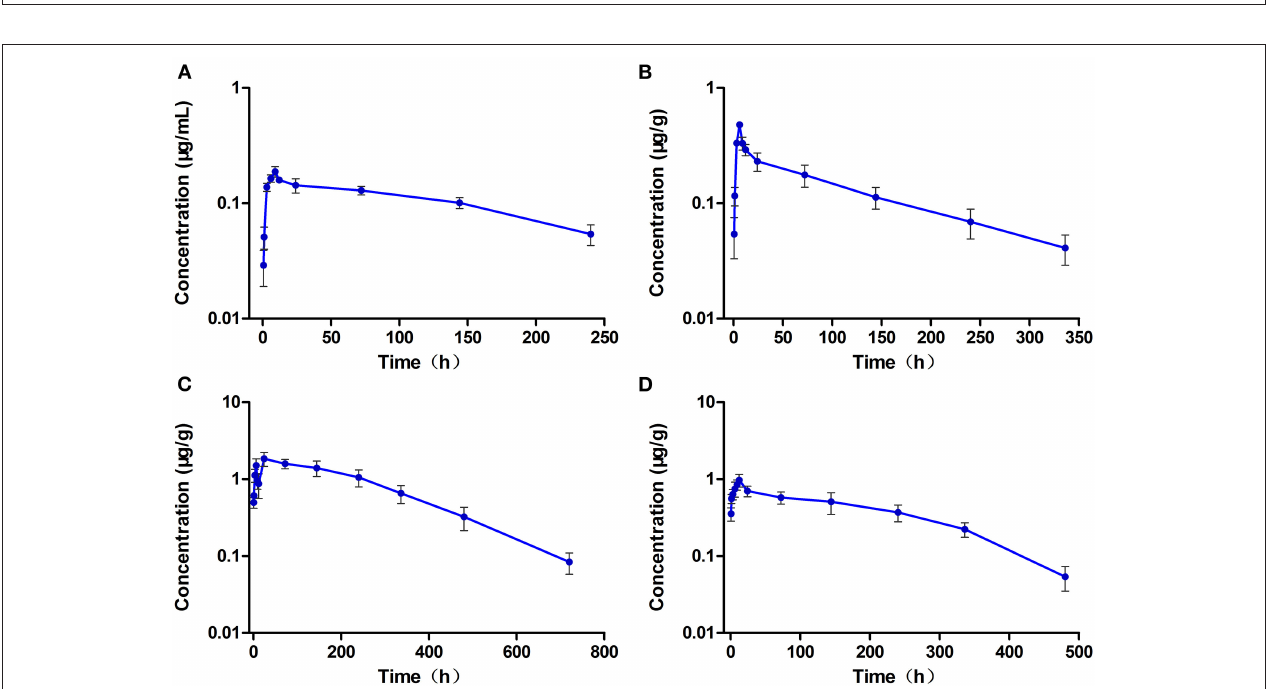
FIGURE 3 | The concentration vs. time curves of ciprofloxacin in the plasma (A) , muscle/skin (B) , liver (C) , and kidney (D) of crucian carp after a single oral dose of enrofloxacin (20 mg/kg b.w.) at 28 ◦ C ( n = 6).